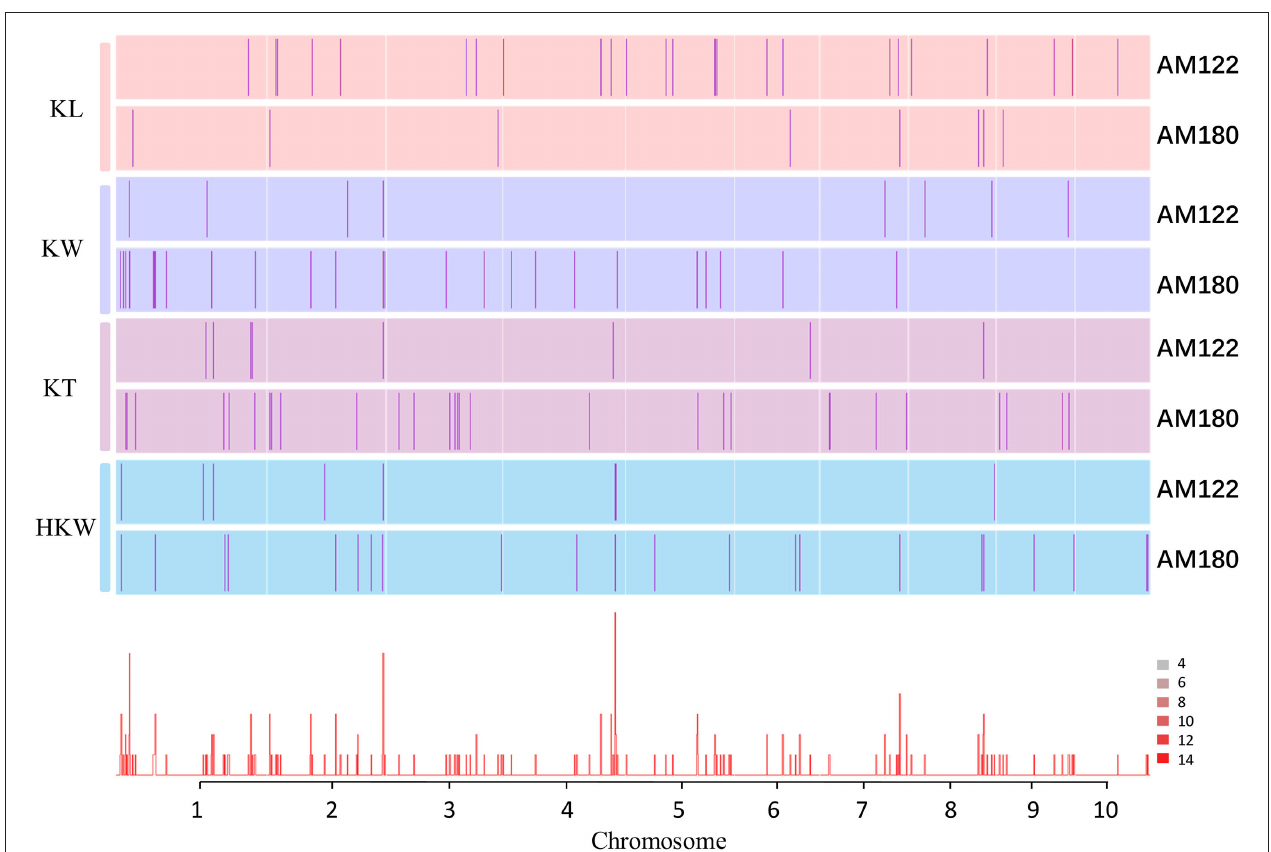
FIGURE 2 | Distribution of associated SNPs of four kernel-related traits using two models (FarmCPU and MLM). The vertical line indicates the position of the locus associated with the grain size trait on the chromosome; The scale bar indicates the significance level of association sites. The height of the histogram represents the frequency of the site. AM122 represents SNPs significantly related to all locations in 2019 (19YL, 19UR, 19NX, and 19BLUP); AM180 represents SNPs significantly related to all locations in 2020 (20NX, 20UR, 20ZY, 20TY, and 20BLUP). KL, Kernel length; KW, kernel width; KT, kernel thickness; HKW, hundred-kernel